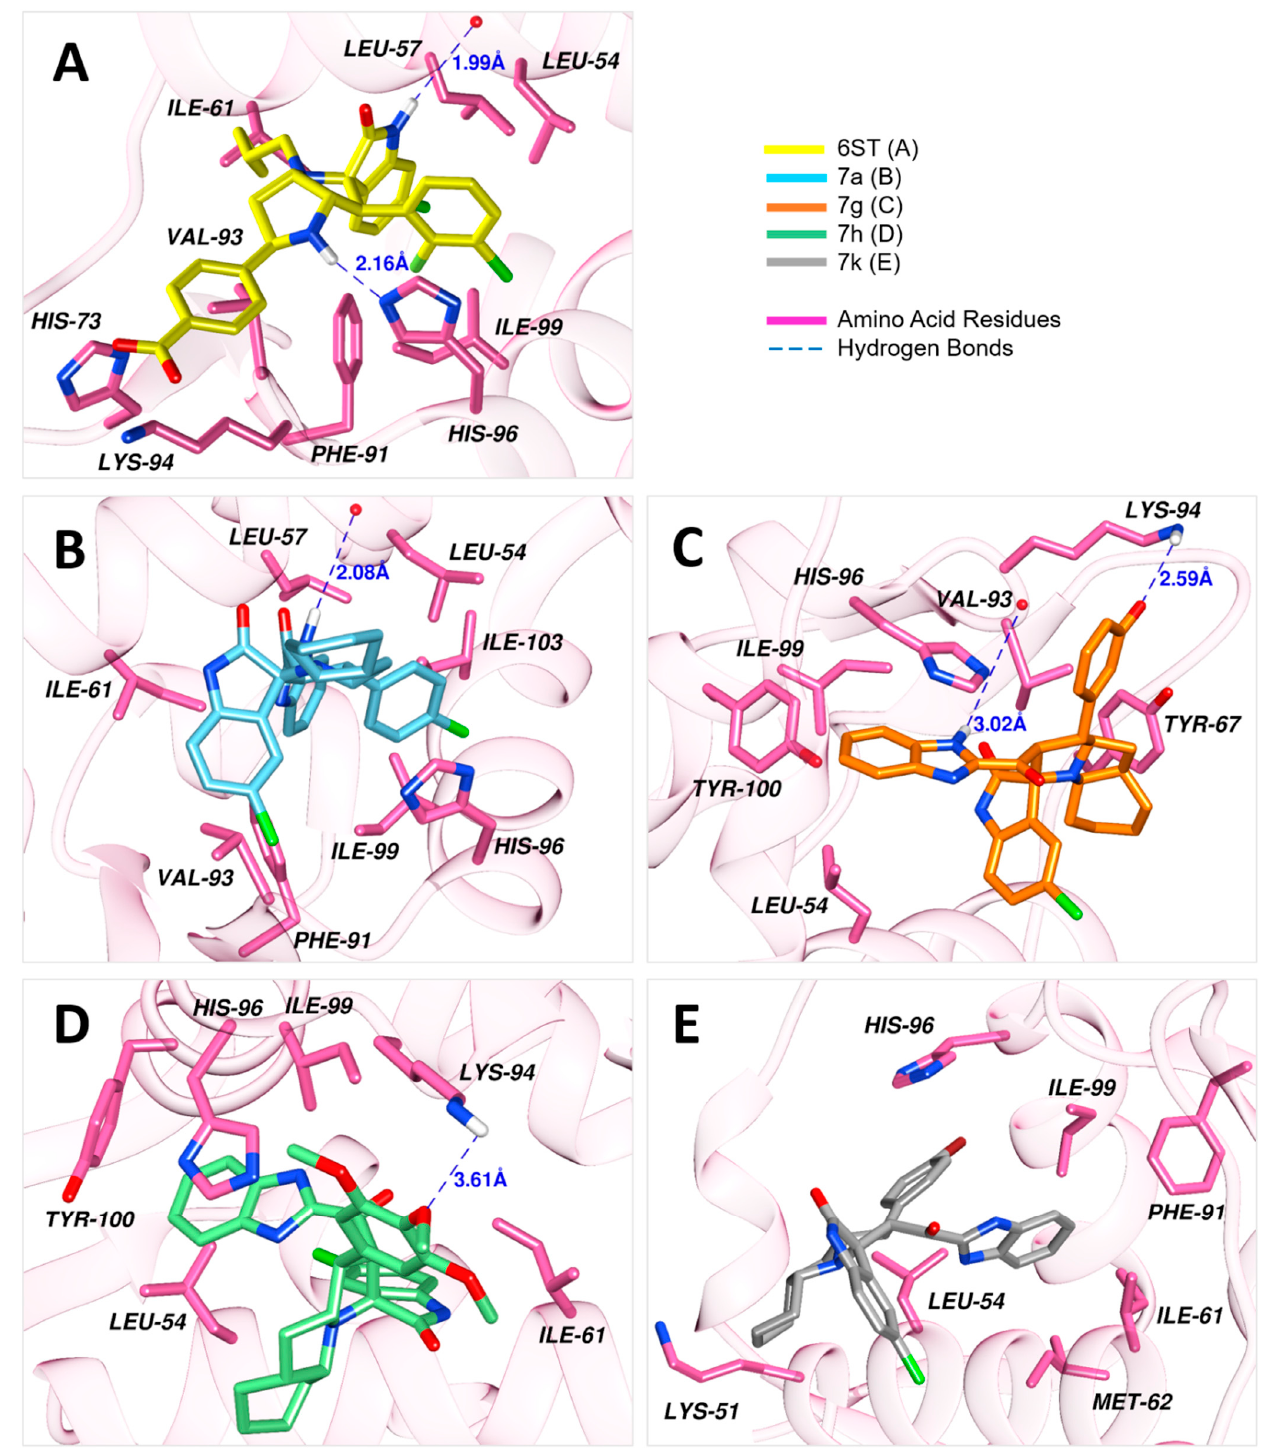
Figure 2. Docked conformations of the ligands into the binding site of MDM2 (PDB ID: